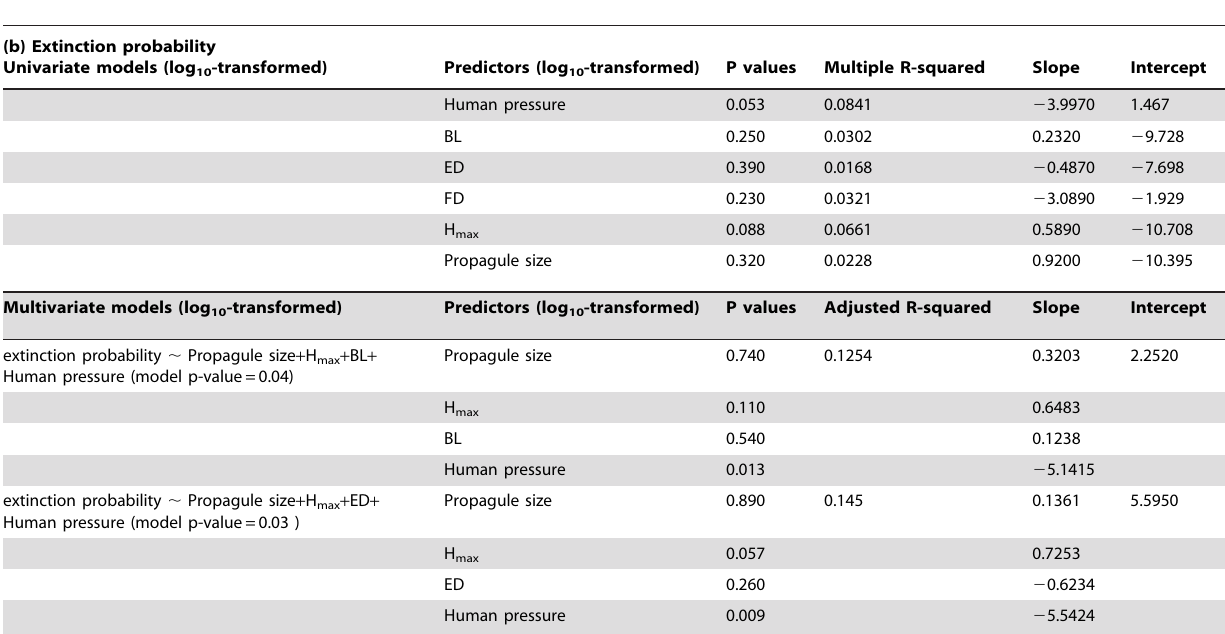
Table 2. Model coefficients for the PGLS models of extinction risk in mangrove ecosystems.